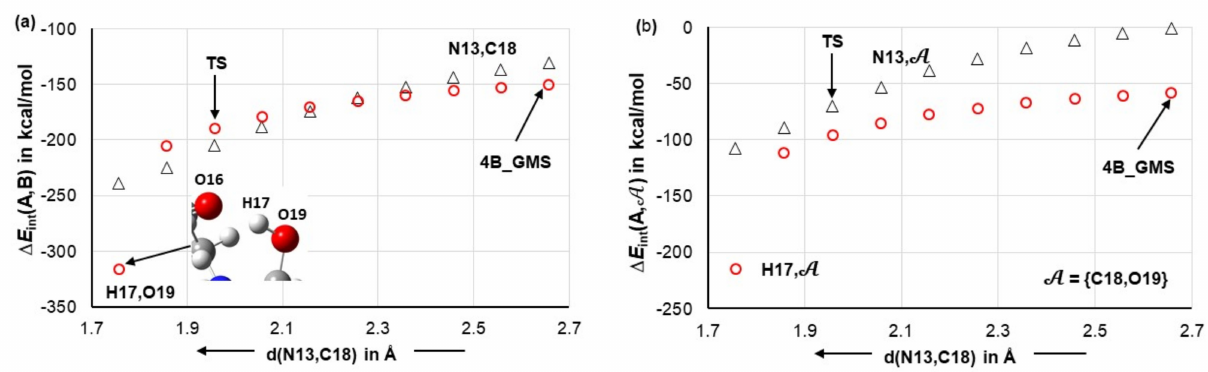
Figure 13. Trends in the interaction energy computed for the N13,C18 and H17,O19 atom-pairs (part ( a )) and N13, A and H17, A atom-molecular fragment pairs (part ( b )). They were obtained on simulated CN-bond formation by scanning d(C18,13) from the value observed in the 4B_GMS